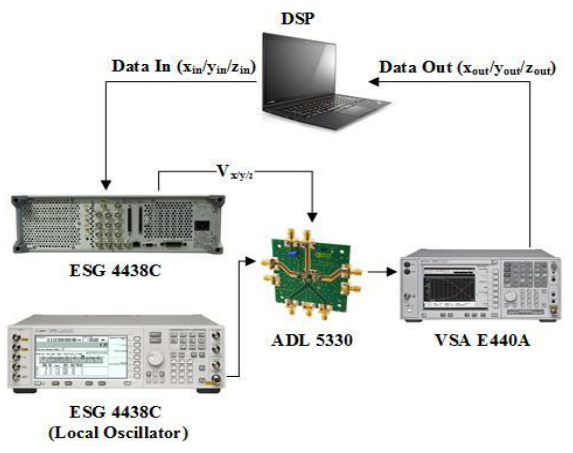
Figure 8. Branch-by-branch implementation of a mixer-less three-way amplitude modulator-based transmitter using digital combining.